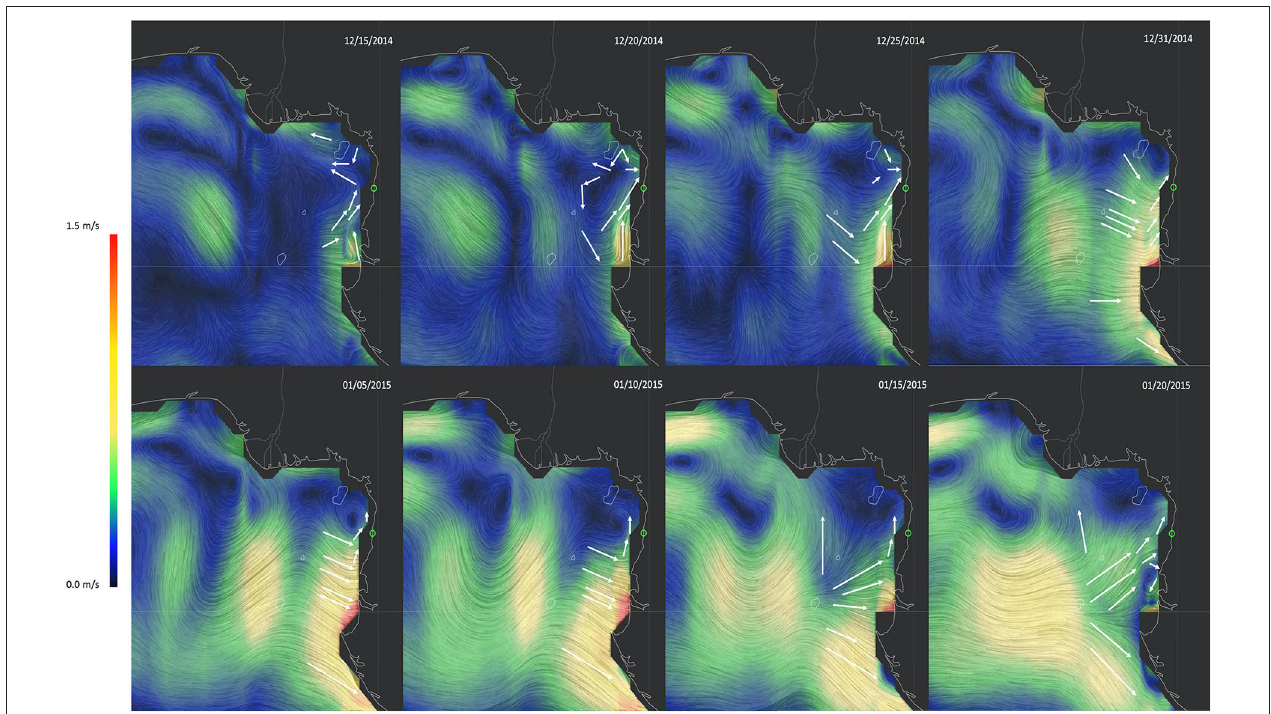
FIGURE 5 | Ocean current patterns in the months of December 2014 and January 2015 (when we collected samples) show a predominant south to north direction of movement. These surface ocean current patterns are based on data of Earth and Space Research’s (ESR) Ocean Surface Current Analysis Real-time (OSCAR) model (https://www.esr.org/research/oscar/oscar-surface-currents/); and the visualization of this OSCAR data is done by Cameron Beccario